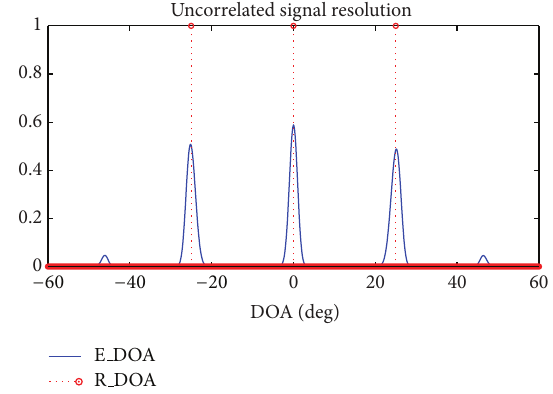
Figure 12: Uncorrelated signal resolution simulation based